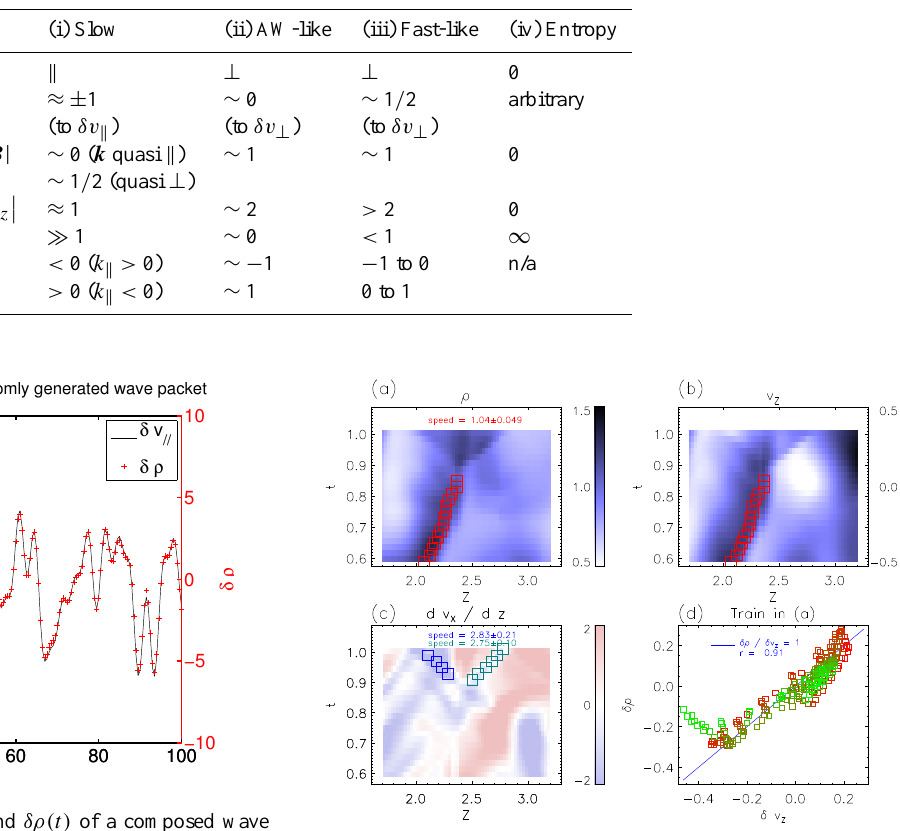
Table 1. Features of MHD waves.